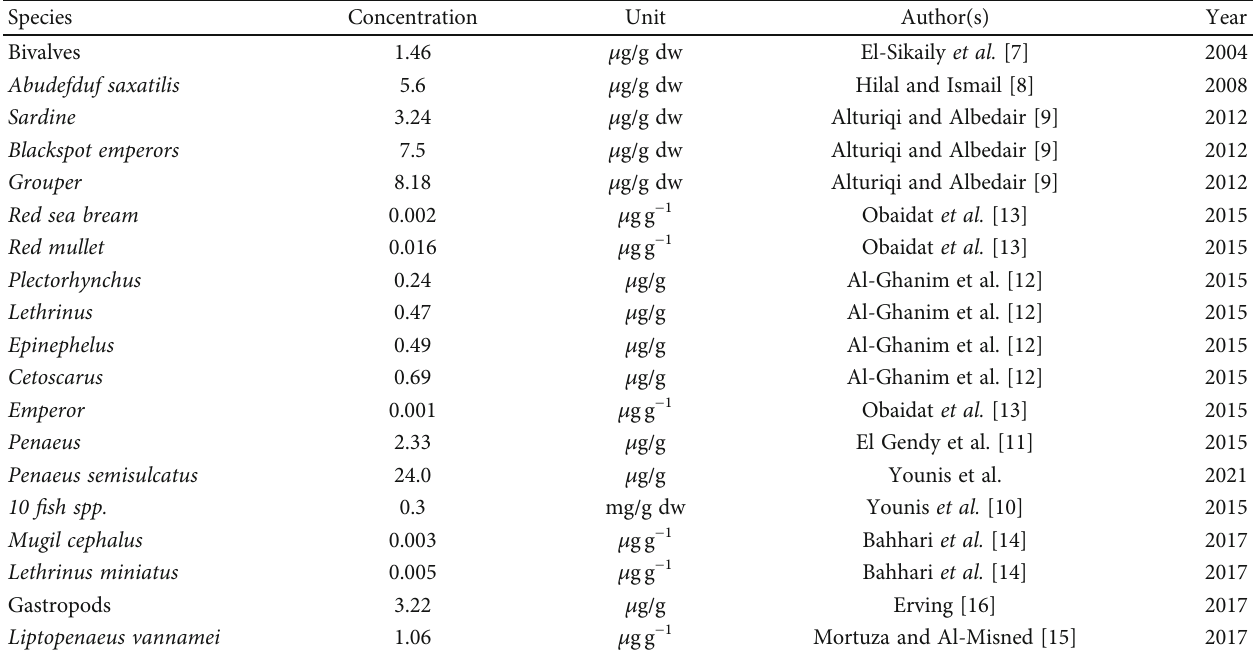
Table 5: Bioaccumulation of lead reported from the Red Sea.